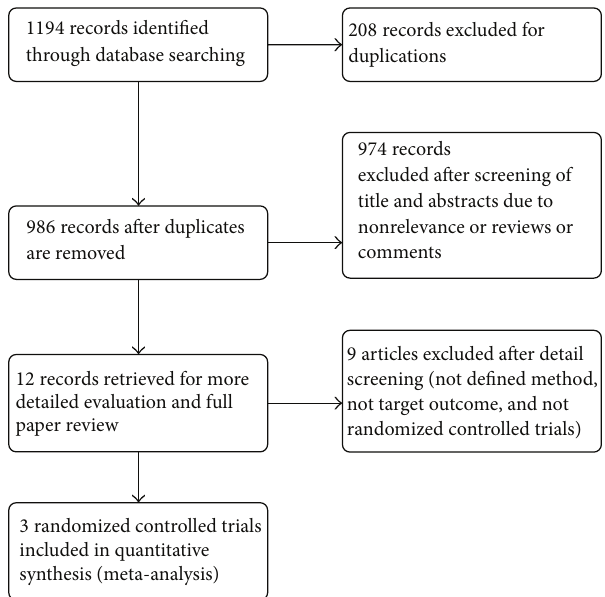
Figure 1: Flow diagram on literature